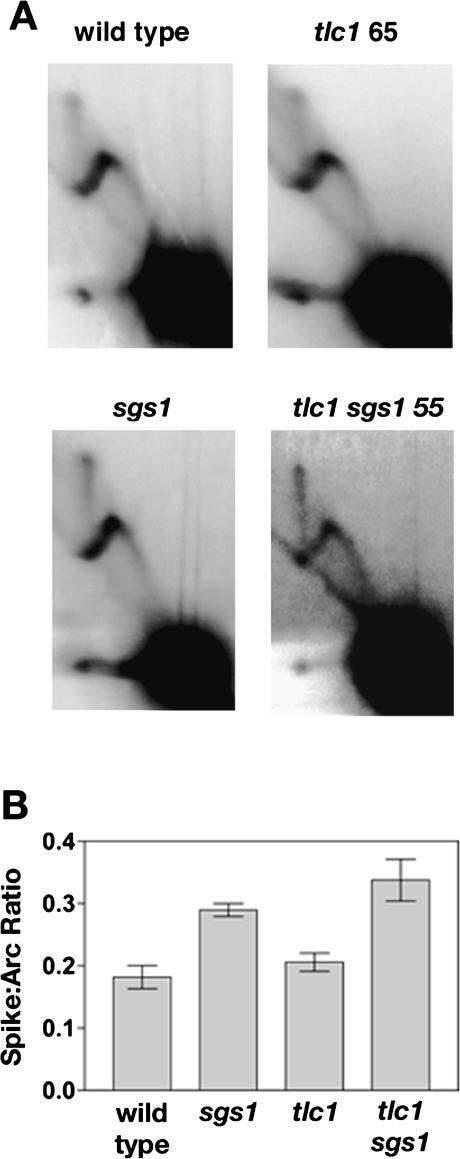
X-Structure Levels in the Ribosomal DNA in Wild-Type, sgs1, tlc1, and tlc1 sgs1 Cells(A) Genomic DNA was isolated from log-phase cultures of the indicated genotypes and PDs, and was digested with SnaBI, separated by 2DGE, and visualized with a probe against the 18S rDNA region.(B) rDNA X-structure levels were quantified in comparison to replication arc levels (spike:arc ratio) in samples obtained from three independent cultures each of wild-type, and sgs1, tlc1, and tlc1 sgs1 mutant cells; means and standard errors are shown. rDNA X-structure levels were elevated by sgs1 mutation (wild type vs. sgs1: p = 0.007; tlc1 vs. tlc1 sgs1 p = 0.023), but were not elevated by tlc1 mutation.